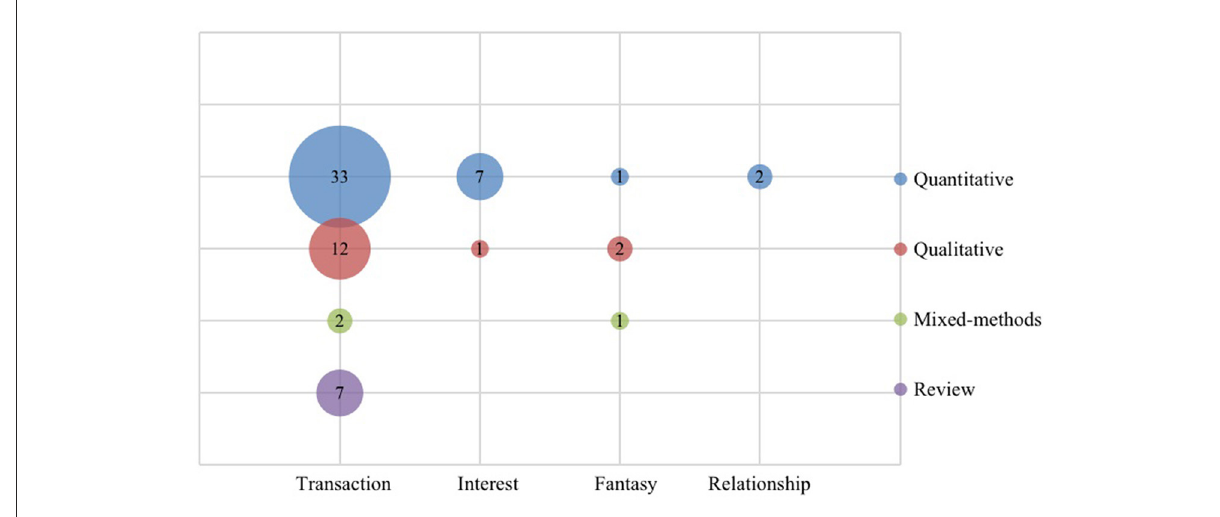
FIGURE5 Selected articles by methods and types of virtual